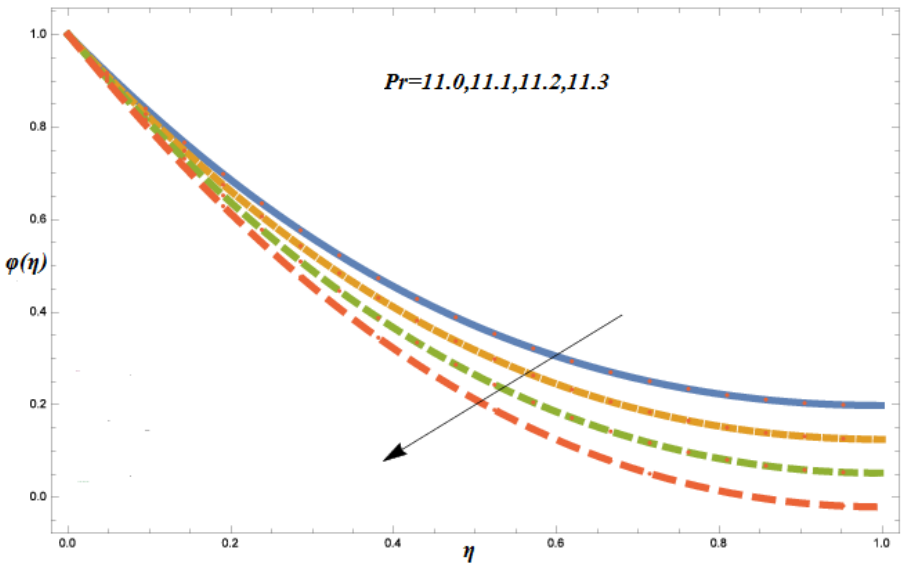
Figure 12. Variations in concentration field ϕ ( η ) occur for different values of Pr , when (cid:125) = − 0.25, S = 0.7, B r = 0.7, N r = 0.7, D u = 0.7, S c = 0.7, ε = 0.7, S r = 0.7, λ = 0.7, Λ = 0.7, β = 1.